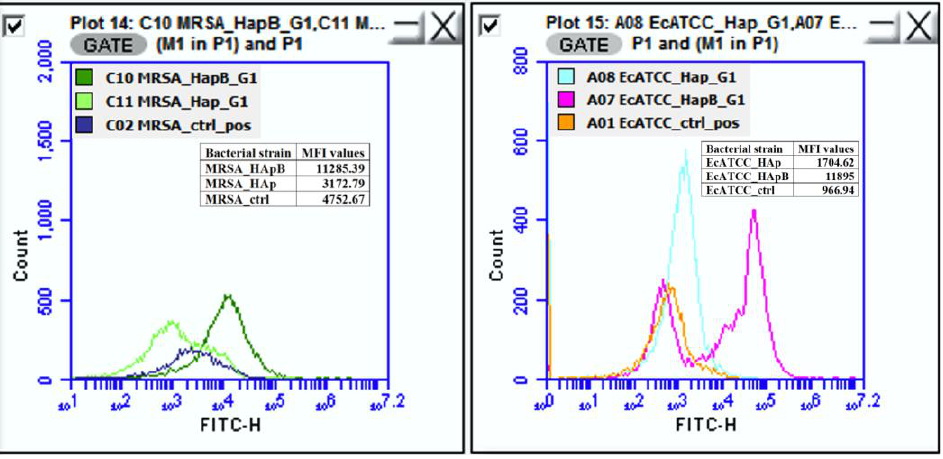
Figure 7. Overlays of control populations (not treated) onto exposed cells to HAp alone and HApB, respectively.